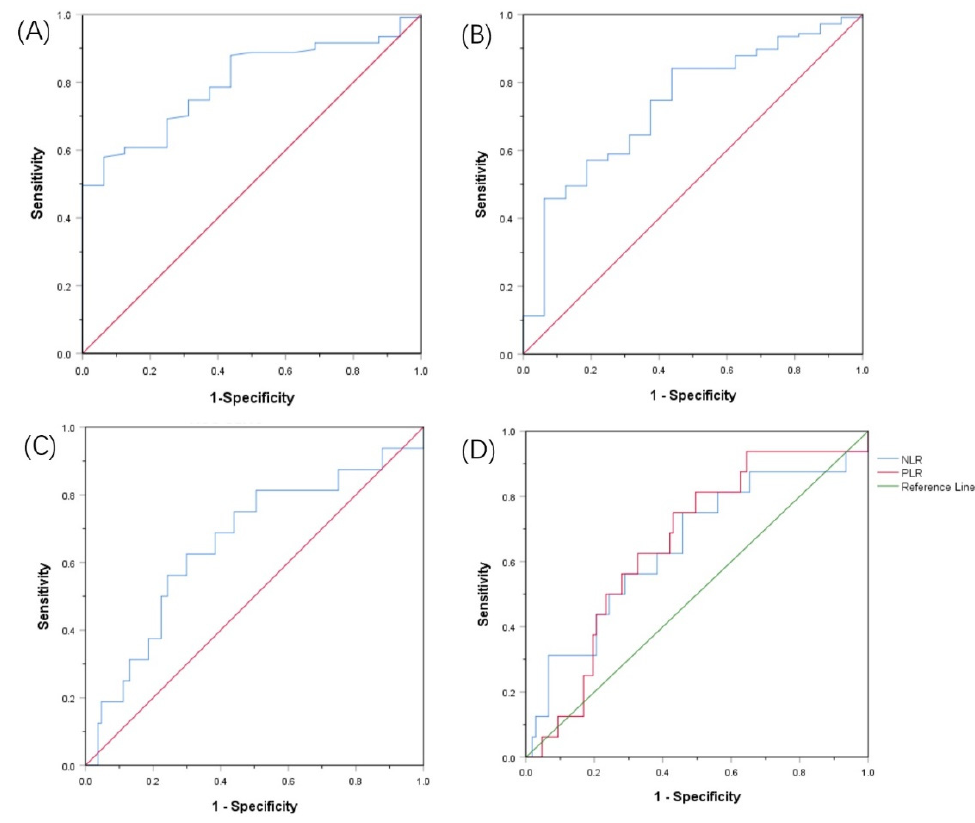
Figure 1. Receiver operating characteristic curves for pretreatment: ( A ) PNI, ( B ) AGR, ( C ) SII, ( D ) RLR and NLR based on OS.